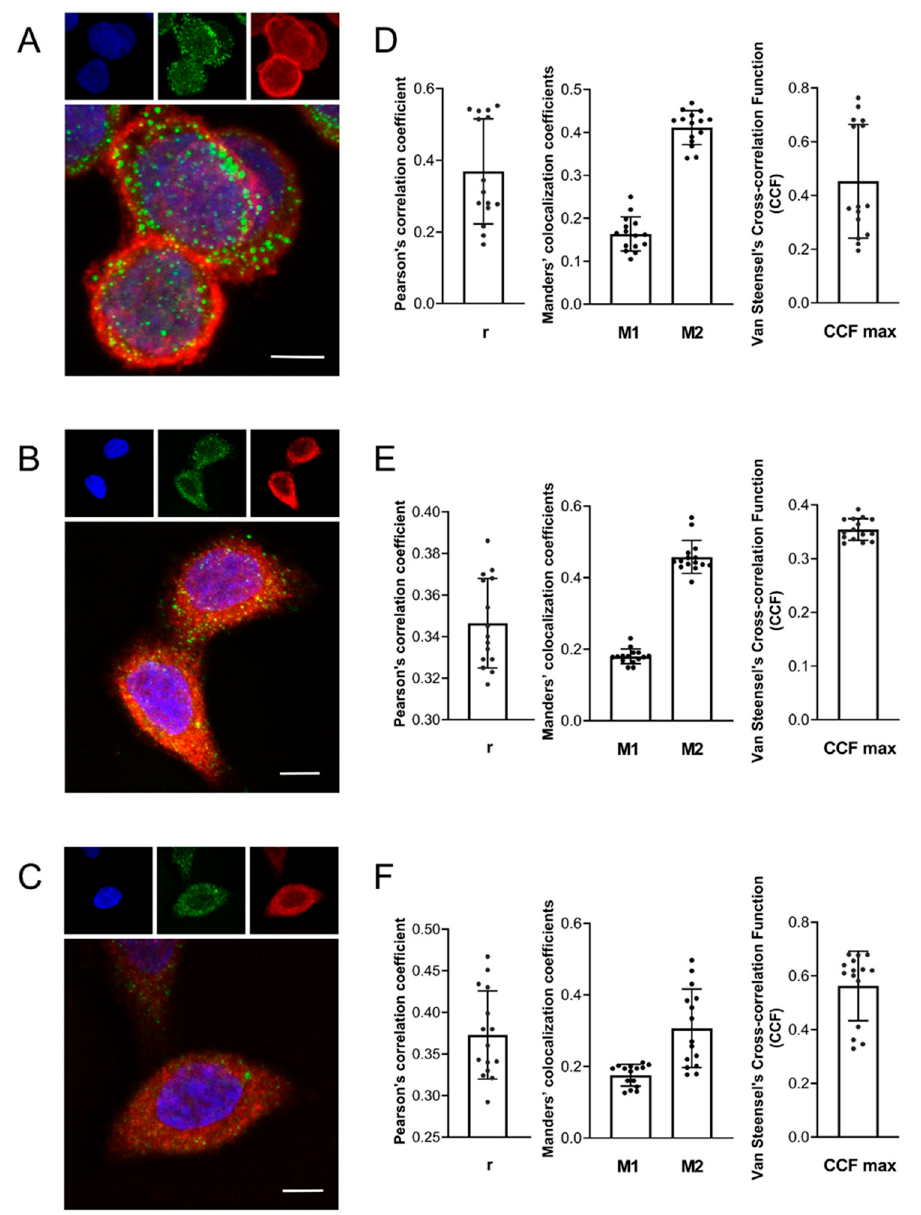
Figure 8. Representative images of confocal laser scanning microscopy and 3D colocalization analysis of AQP3 ( A , D ), AQP8 ( B , E ) and AQP11 ( C , F ) with S1R. Green labeling indicates the presence of S1R, red labeling the expression of AQP3 ( A ), AQP8 ( B ) and AQP11 ( C ), while nuclei were counterstained by Hoechst (blue). Yellow labelling shows colocalization signal of AQP with S1R. Scale bar, 5 µ m. ( D – F ) Statistical analysis of Pearson’s correlation coefficient r, Manders’ colocalization coefficient (M1 and M2) and Van Steensel’s maxima Cross-Correlation Function (CCF) were obtained from 4 different double immunofluorescence experiments with anti-S1R antibody and anti-AQP3, AQP8 and AQP11 antibodies. Coefficients were determined by 3D analysis for each z-stack (8–15) using the JACoP plugin of Fiji. Each dot of the column represents one single field including different number of cells. The columns represent the mean ± SD of the coefficient values.